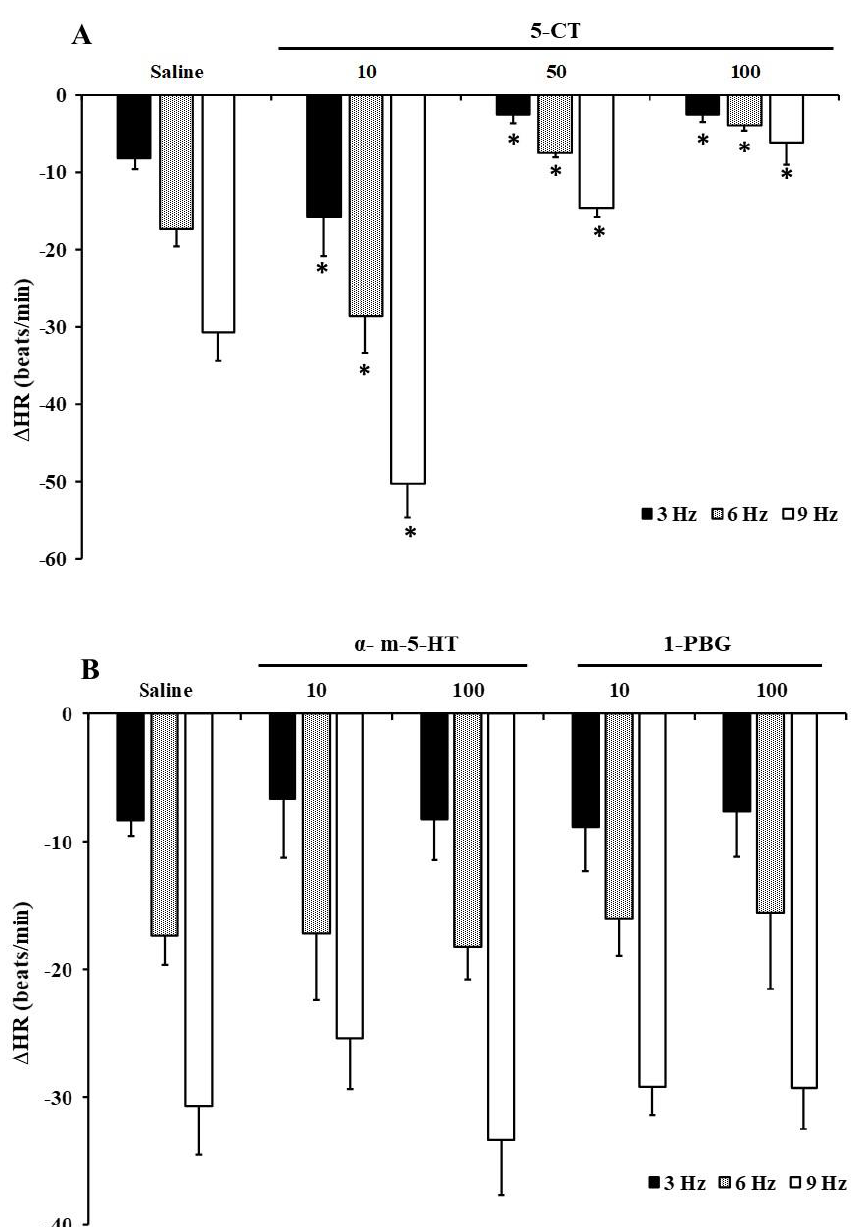
Figure 1. Effect of 5-HT receptor type agonists on the vagally-induced bradycardic responses in fluoxetine-treated diabetic rats. Effect of i.v. bolus injections of saline (1 mL/kg) and ( A ) 5-CT (10, 50 and 100 µ g/kg; n = 5 for each dose) or ( B ) α -methyl-5-HT ( α -m-5-HT) and 1-phenylbiguanide (1-PBG) (10 and 100 µ g/kg each agonist; n = 5 for each treatment and dose) on the decreases in heart rate ( ∆ HR) evoked by electrical vagal stimulation (3, 6 and 9 Hz) in fluoxetine-treated diabetic pithed rats. * p < 0.05 versus saline.